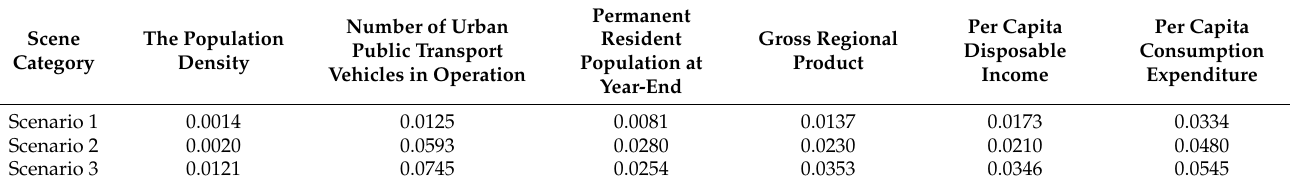
Table 6. Growth rate of each indicator under different